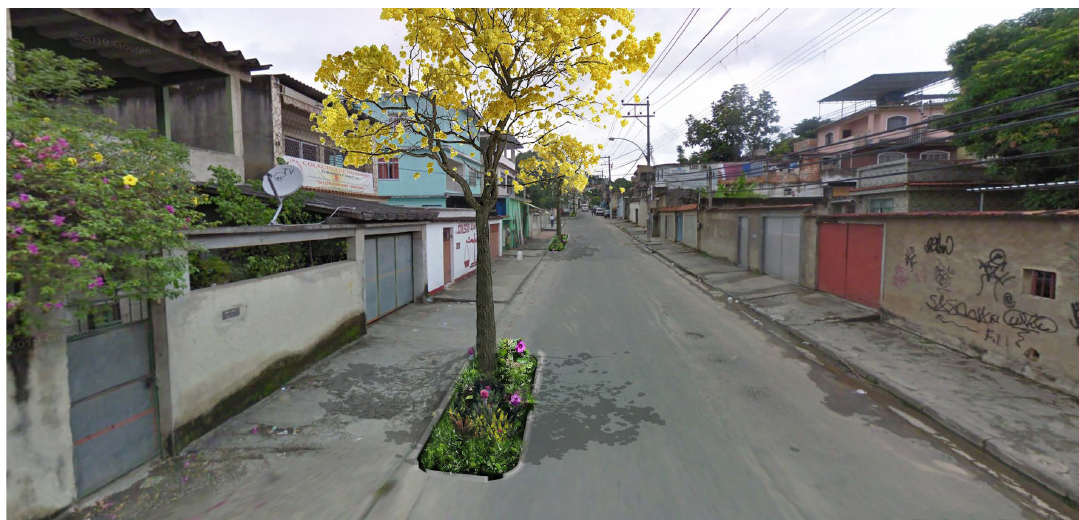
Figure 8. Visualisation of Pavuna